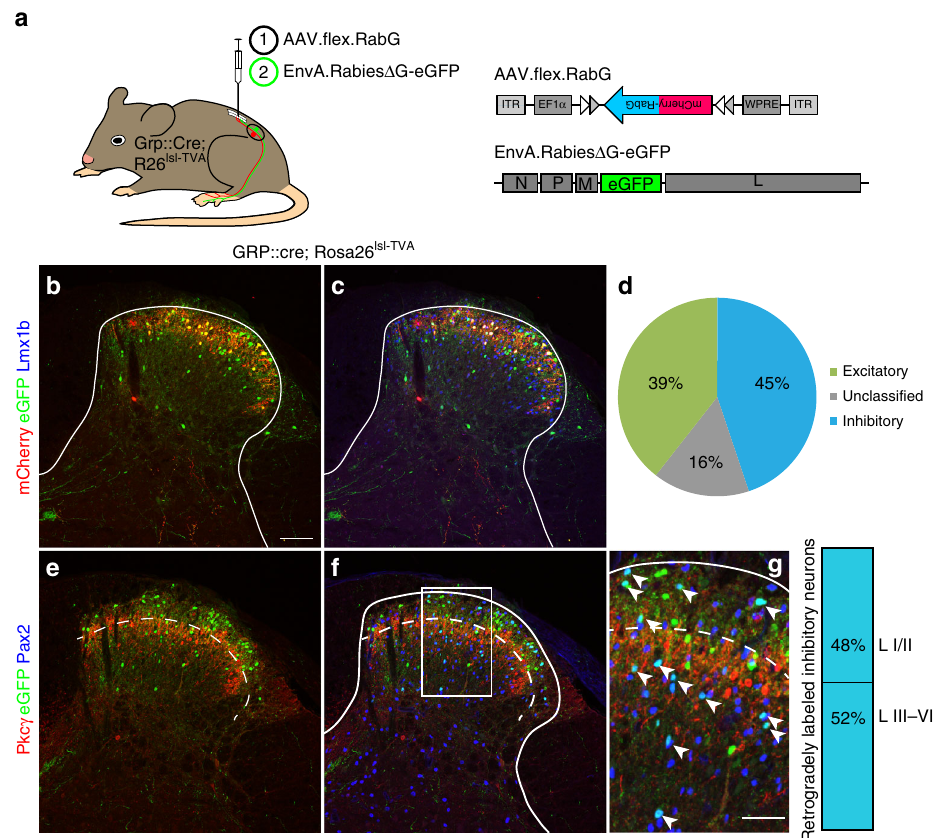
Fig. 1 Inhibitory input onto spinal GRP positive itch relaying interneurons. a Neurons providing synaptic input onto GRP positive neurons were identi fi ed using transsynaptic rabies virus based tracing. GRP::cre;ROSA26 TVA mice ( n = 3) were fi rst injected with AAV. fl ex.mCherry-RabG into the left lumbar spinal cord, and 14 days later with an EnvA pseudotyped glycoprotein de fi cient rabies virus (EnvA.Rabies Δ G-eGFP). b – g Transverse sections of the injected dorsal horn. Cre positive GRP neurons infected with AAV. fl ex.RabG (red) primary and secondary Rabies virus infected neurons (green). Co-staining with Lmx1b and Pax2 revealed excitatory and inhibitory neurons, respectively. b primary rabies virus infected neurons express eGFP and mCherry, and appear yellow. Secondary rabies virus infected neurons are green only. c Co-staining with Lmx1b (blue) reveals the excitatory population of secondary infected (transsynaptically labeled) neurons (magenta; eGFP and Lmx1b positive but mCherry negative) d Classi fi cation of transsynaptically labeled neurons as excitatory (39%, Lmx1b positive) or inhibitory (45%, Pax2 positive). 16% of transsynaptically infected neurons (eGFP positive but mCherry negative) were neither stained with antibodies against Lmx1b or Pax2, and remained unclassi fi ed. e Co-staining with PKC γ (red) indicates border between lamina II and III. mCherry was not visible in e-g because it required signal ampli fi cation by an mCherry antiserum. f Co-staining against Pax2 revealed transsynaptically labeled inhibitory neurons (magenta; Pax2 and eGFP positive). Scale bar, 100 µ m. We did not fi nd any mCherry/eGFP/Pax2 triple positive neurons (not shown) consistent with the known excitatory phenotype of spinal GRP neurons 22 . g Higher magni fi cation of the area indicated in f . Arrow heads indicate rabies virus infected (eGFP positive) inhibitory (Pax-2 positive) neurons. Of the inhibitory transsynaptically labeled neurons, 48% were in laminae I/II and 52% in laminae III/IV. Quanti fi cations were performed on 9 sections obtained from 3